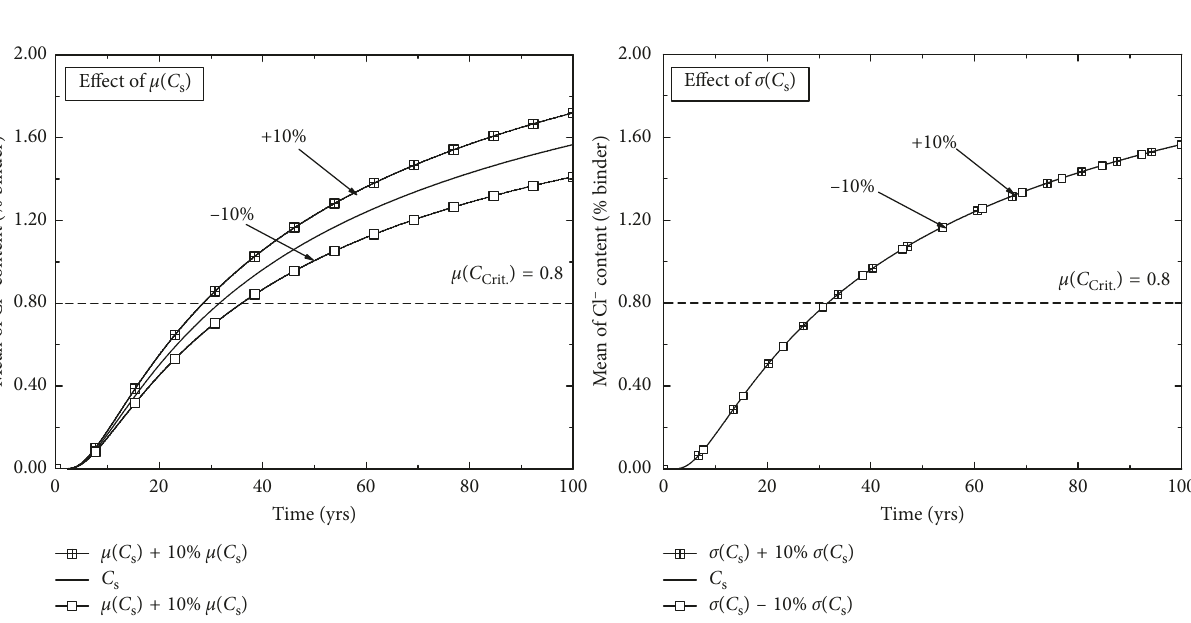
Figure 11: Sensitivity of C s to chloride profiles in concrete without repair.